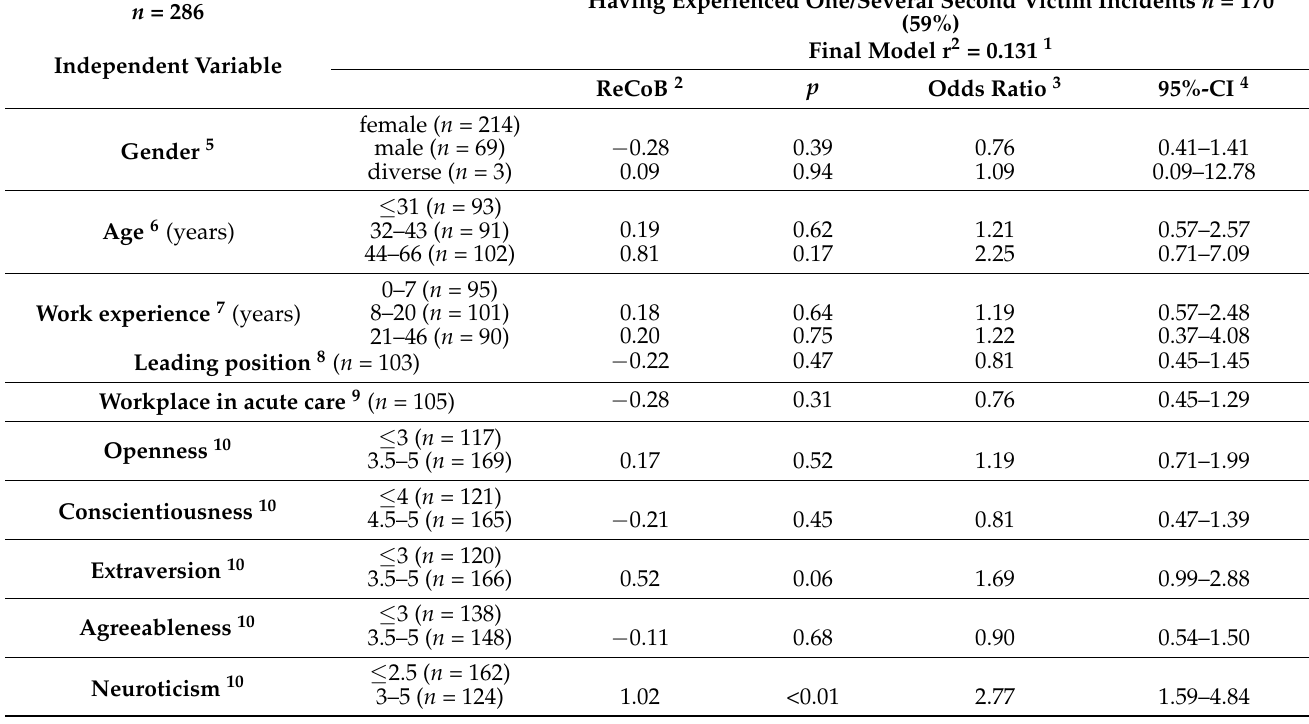
Table 4. Risk factors for being a second victim.